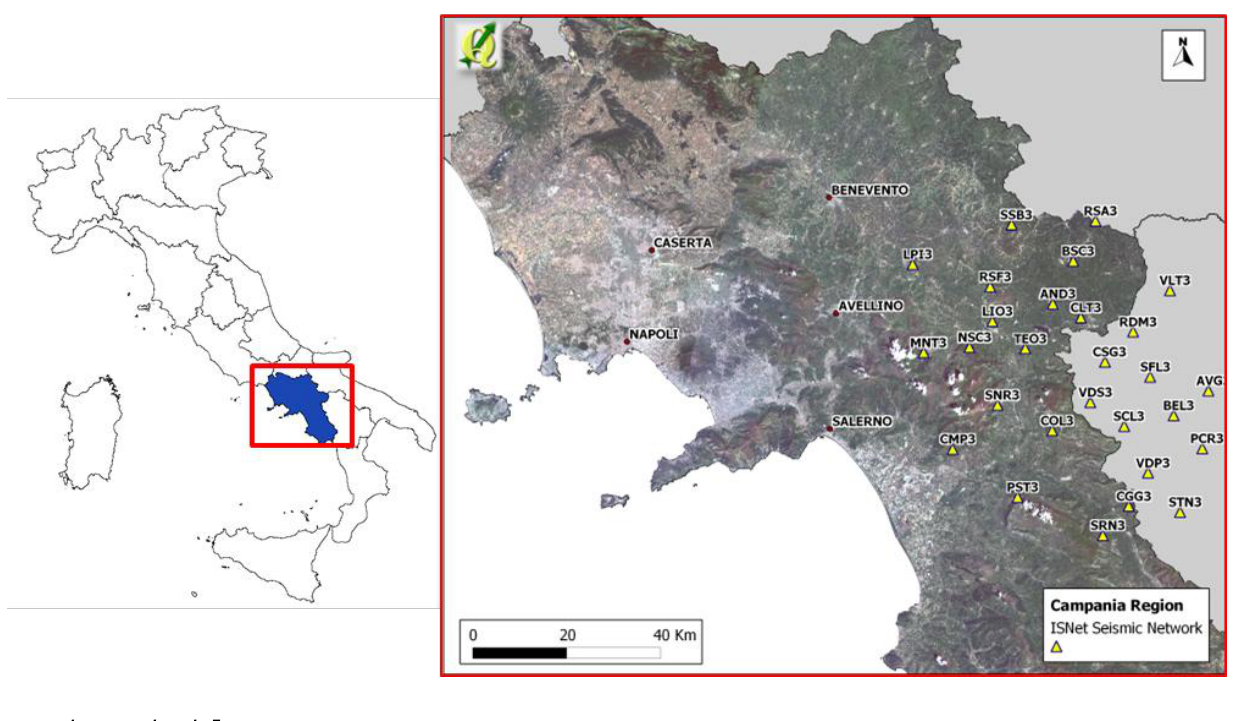
Figure 1. Study area and geographic location of Irpinia Seismic Network